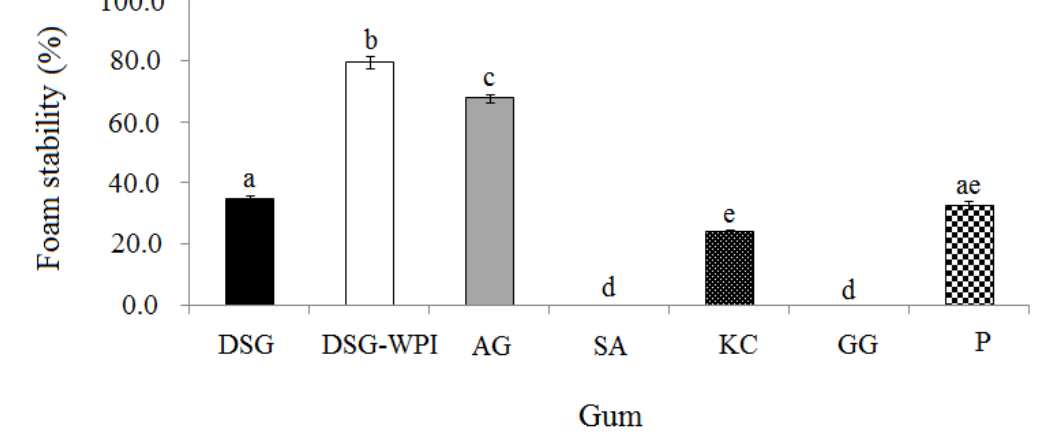
Figure 3. Foaming stability of the non-conjugated durian seed gum (DSG) and conjugated durian seed gum (DSG-WPI) as compared to other commercial gums ( i.e. , Arabic gum (AG), sodium alginate (SA), kappa carrageenan (KC), guar gum (GG), and pectin (P); a – e : significant different at p <